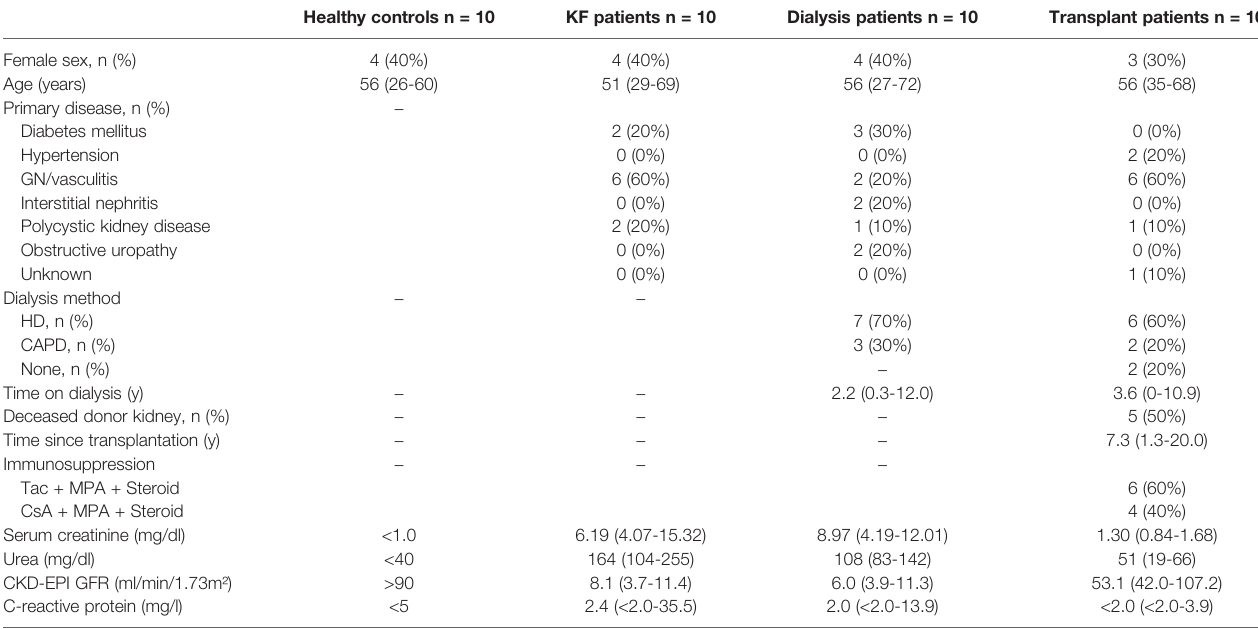
TABLE 2 | Clinical characteristics for the functional CD8 + Tresp